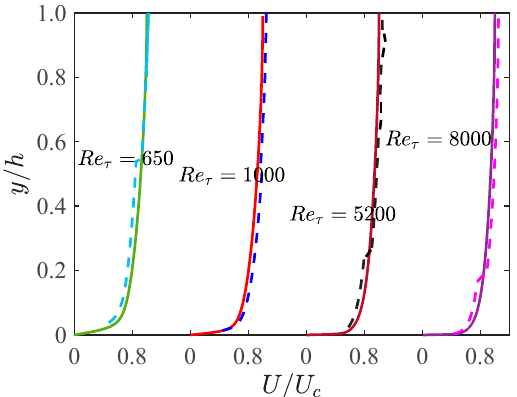
Figure 11. Comparison of solved axial mean-velocity U by TQEVM (dash line) and DNS (solid line) for four different cases of channel flow: Re τ = 650, Re τ = 1000, Re τ = 5200 and Re τ = 8000 (from left to right), where h is the half-height of the channel and U c is axial mean velocity at the channel centerline.